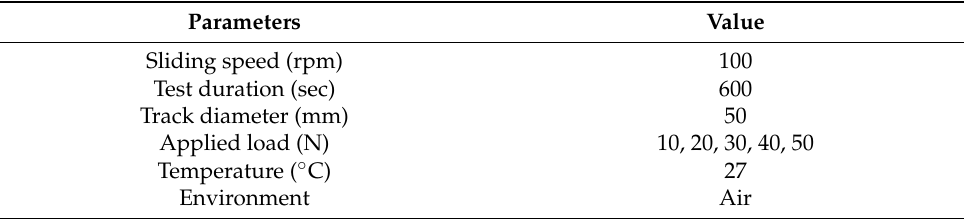
Figure 3. Pin-on-disk wear test equipment. Table 1. Testing parameters for tribology